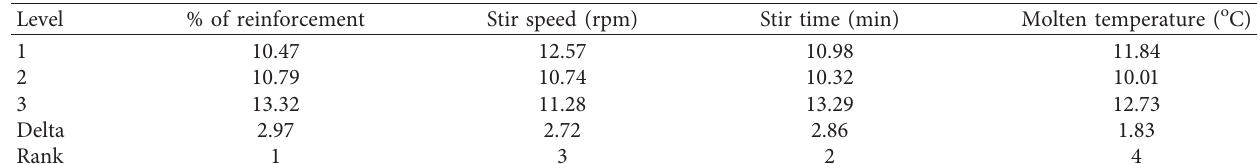
Table 5: Response table for signal-to-noise ratios. Smaller is better.